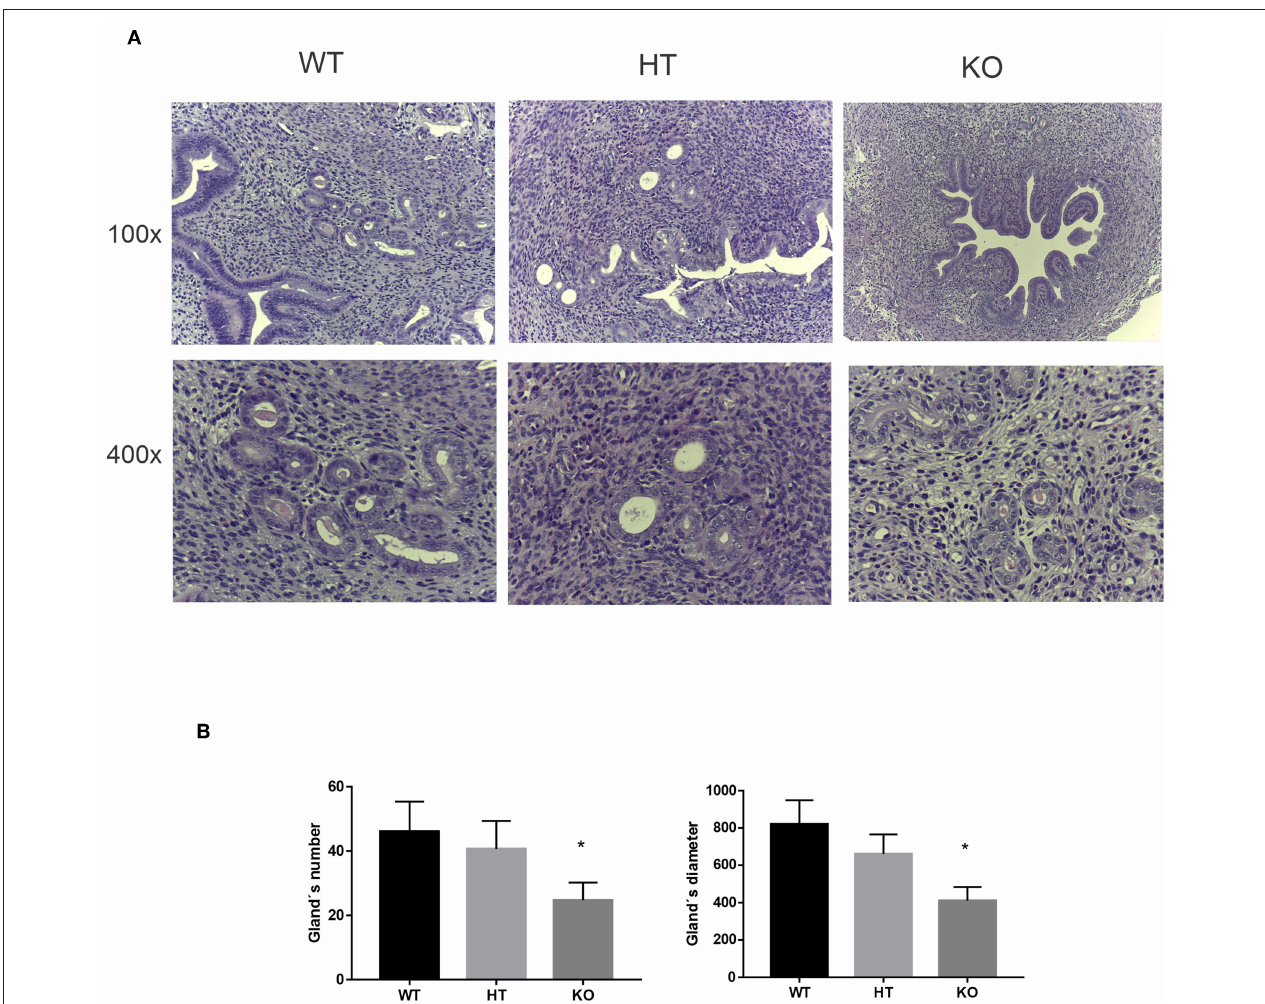
FIGURE 3 | Vasoactive intestinal peptide (VIP)-deficient mice show a reduction in number and size of the uterine glands. Histologic analysis of uterine glands in estrus uterus. (A) Representative example of a cross section of the estrus uterus of VIP − / − , VIP + /–, and VIP + / + in 100 × , showing a detail of the glandular mesenchyme in 400 × using Leica ICC50 HD, High Definition digital microscope camera. (B) Quantification of number and diameter of glands in 10 slides from each animal and averaged. Values represent mean ± SEM of at least three animals of each genotype (Mann-Whitney test * p <